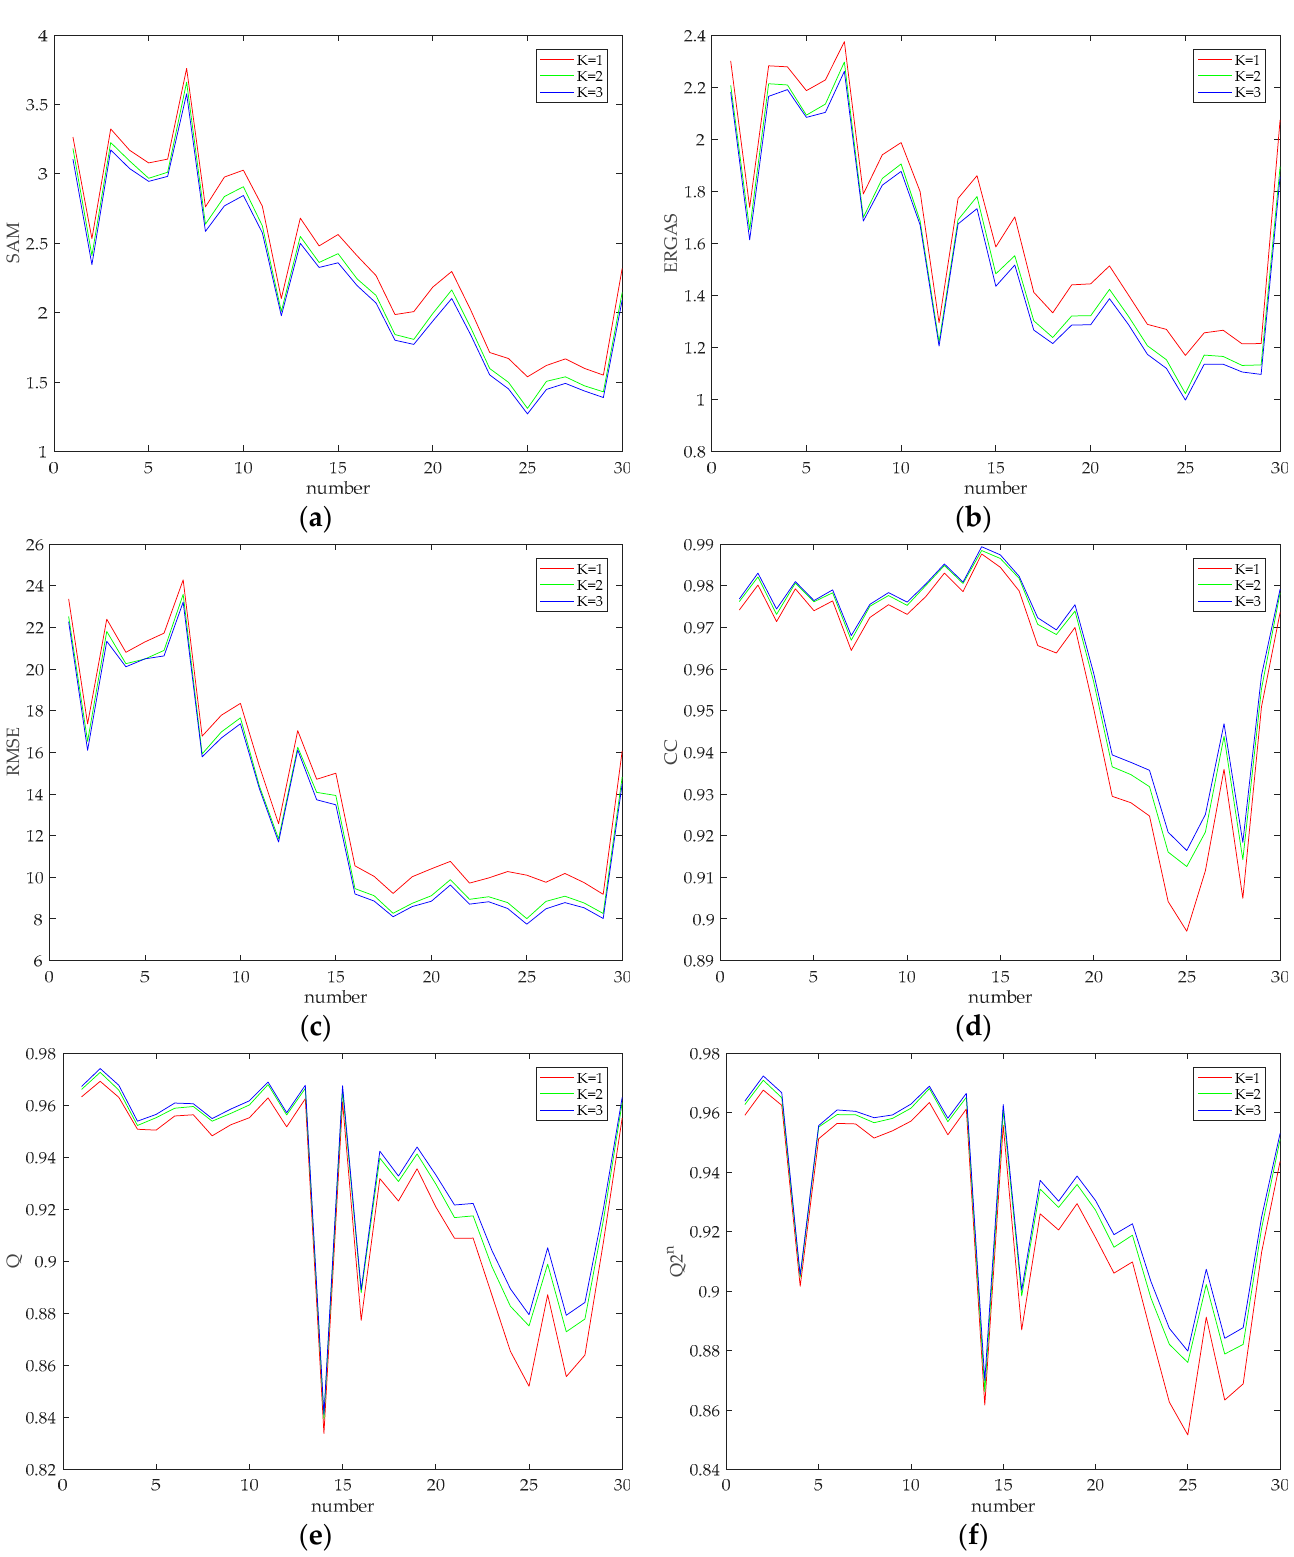
Figure 2. Quality indicator curves of the fused image with network level set to 1, 2, and 3 on the GeoEye-1 dataset. ( a ) SAM; ( b ) ERGAS; ( c ) RMSE; ( d ) CC; ( e ) Q; ( f ) Q2 n